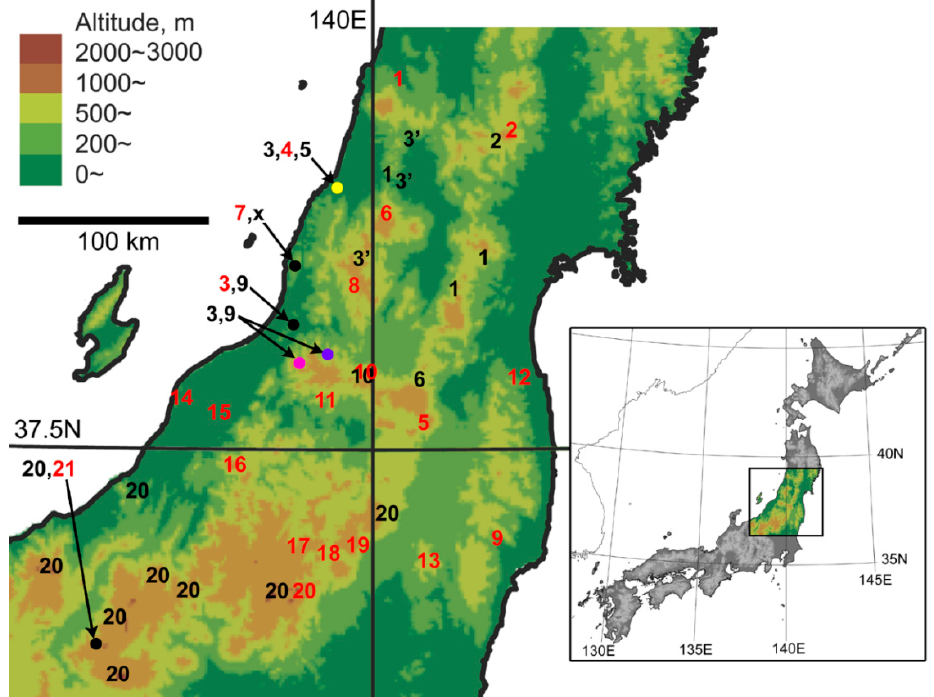
Figure 1. Distribution of the Pterostichus macrogenys species group in northern Chubu, northern Kanto, and southern Tohoku Districts of Honshu, Japan. ( 1) P. chokaisanus Sasakawa, 2009; ( 2 ) P. kurikomasanus Sasakawa, 2005; ( 3 ) P. falcispinus Sasakawa, 2005 “western type”; ( 3 ′ ) P. falcispinus “eastern type”; ( 4 ) P. takadateyamanus Sasakawa, 2009; ( 5 ) P. adatarasanus Sasakawa, 2005; ( 6 ) P. gassanus Sasakawa, 2009; ( 7 ) P. shinbodakensis Sasakawa and Itô, 2017; ( 8 ) P. asahinus Habu and Baba, 1960; ( 9 ) P. iwakiensis Sasakawa, 2009; ( 10 ) P. eboshiyamanus Sasakawa, 2009; ( 11 ) P. tateishiyamanus Sasakawa and Itô, 2017; ( 12 ) P. monolineatus sp. n.; ( 13 ) P. yamizosanus Sasakawa, 2005; ( 14 ) P. yahikosanus Sasakawa, 2009; ( 15 ) P. ohsawacavus Sasakawa, 2005; ( 16 ) P. sumondakensis Sasakawa, 2005; ( 17 ) P. isolatus Sasakawa, 2005; ( 18 ) P. nakamiyorinus Morita, Ohkawa and Kurihara, 2013; ( 19 ) P. momuranus Morita, Ohkawa and Kurihara, 2013; ( 20 ) P. macrogenys Bates, 1883; ( 21 ) P. nagasawai Ito and Ogai, 2015; x unidentified species sympatric with P. shinbodakensis . Red letters indicate the type localities of each species.